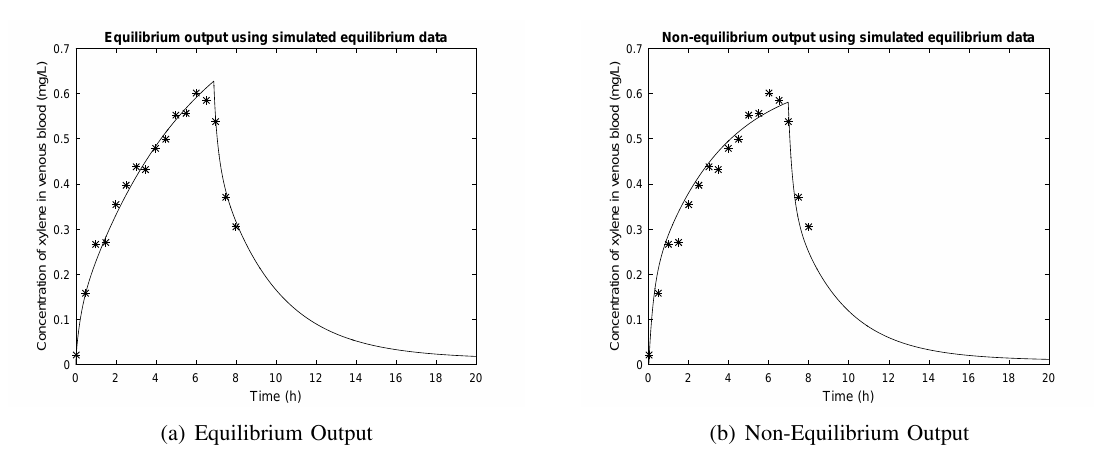
(b) Non-Equilibrium Output Fig. 8. Model output for the concentration of xylene in venous blood after optimization over data simulated from the equilibrium model with noise level 0.05 and V xyl maxc = 2 . Figure (a) contains equilibrium model output and Figure (b) contains non-equilibrium model